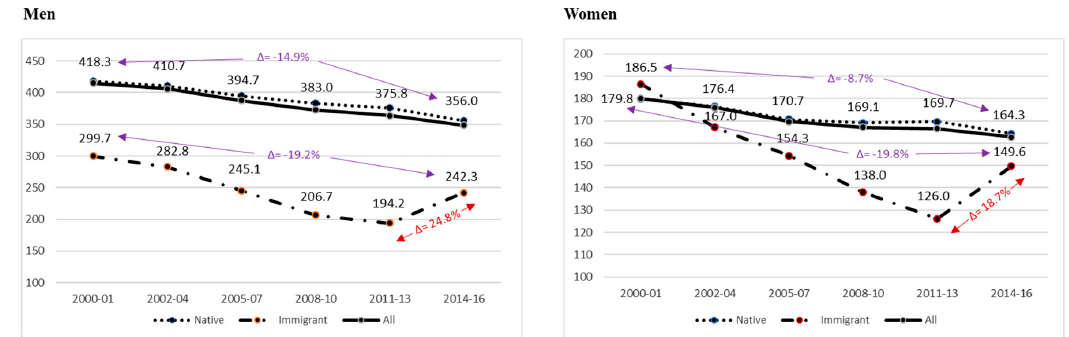
Figure 2. Age-standardized rates of cancer mortality (ASR) per 100,000 people in the immigrant, native, and total populations by sex and sub-period (2000–2016).